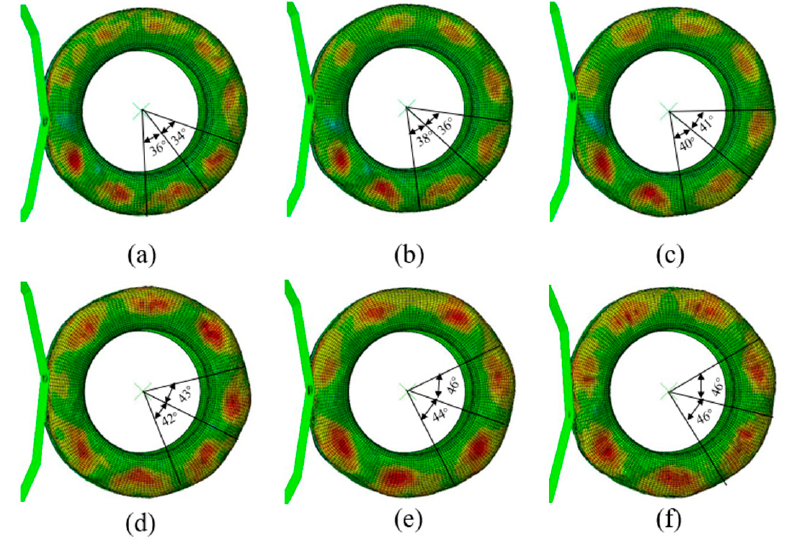
Figure 10. The standing wave deformation of an aircraft tire: ( a ) 200 km/h, ( b ) 220 km/h, ( c ) 240 km/h, ( d ) 260 km/h, ( e ) 280 km/h, ( f ) 300 km/h.